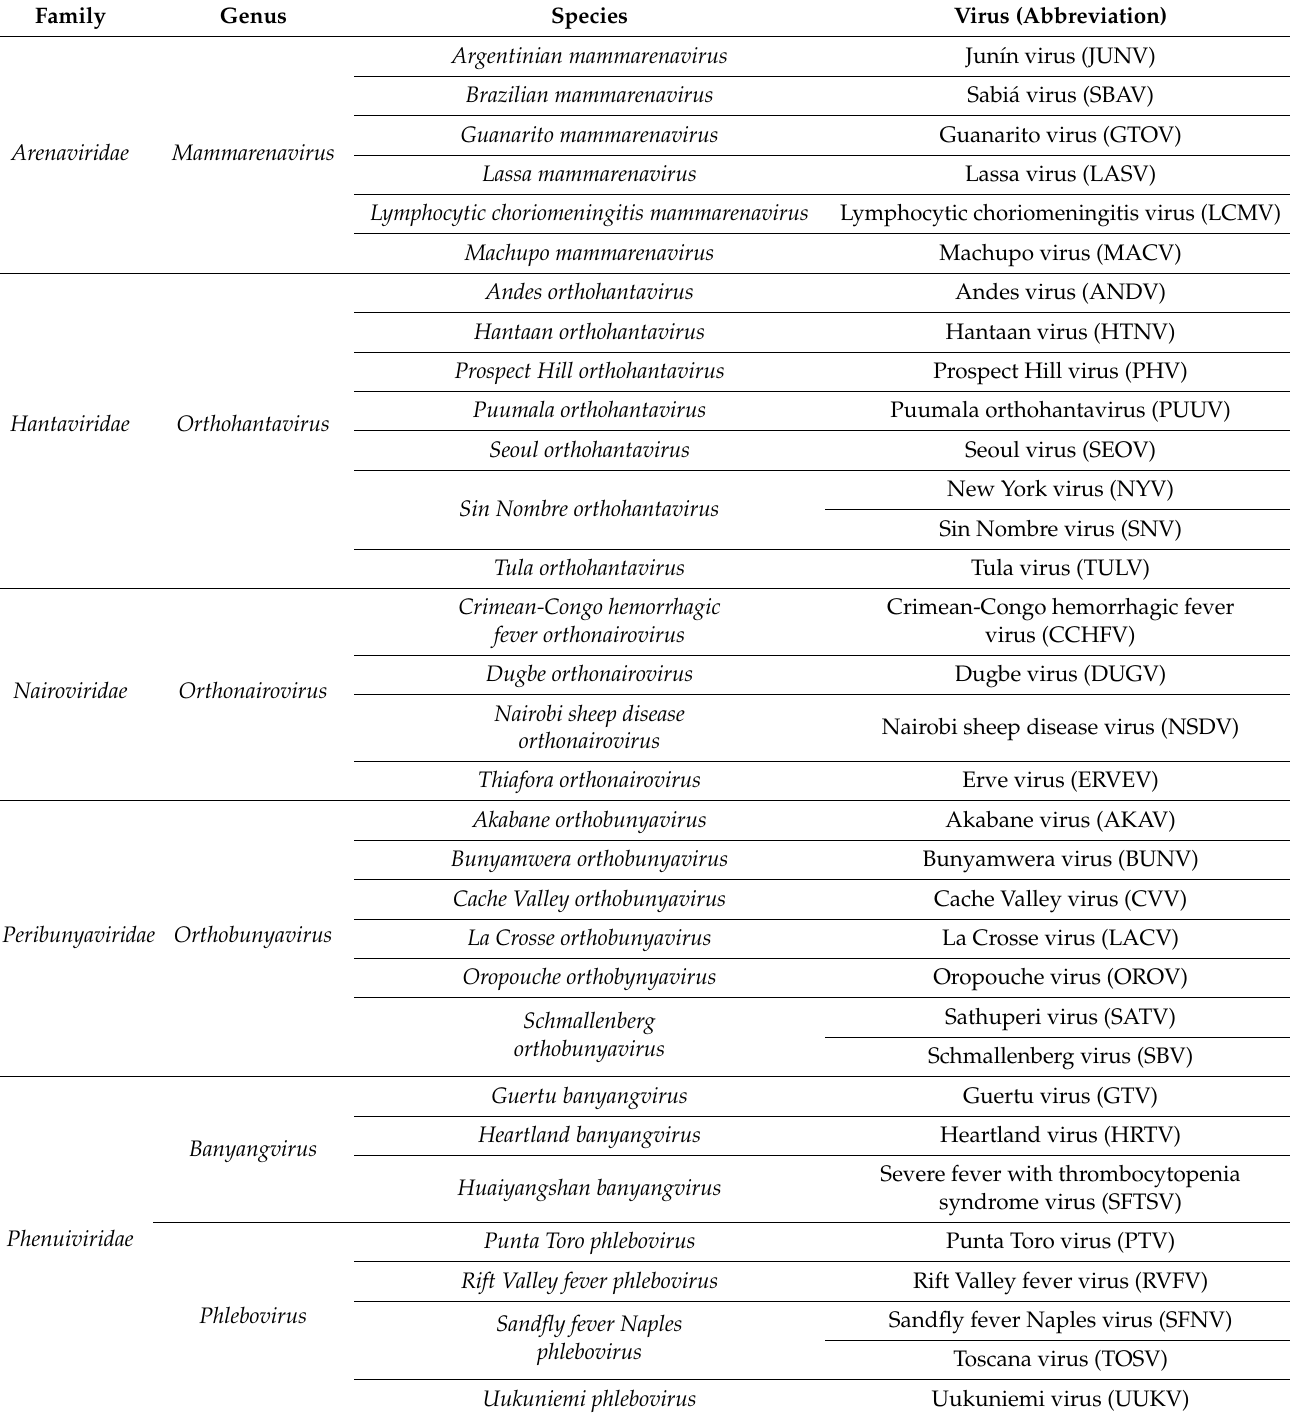
Table 1. Taxonomical classification of bunyaviruses discussed in this